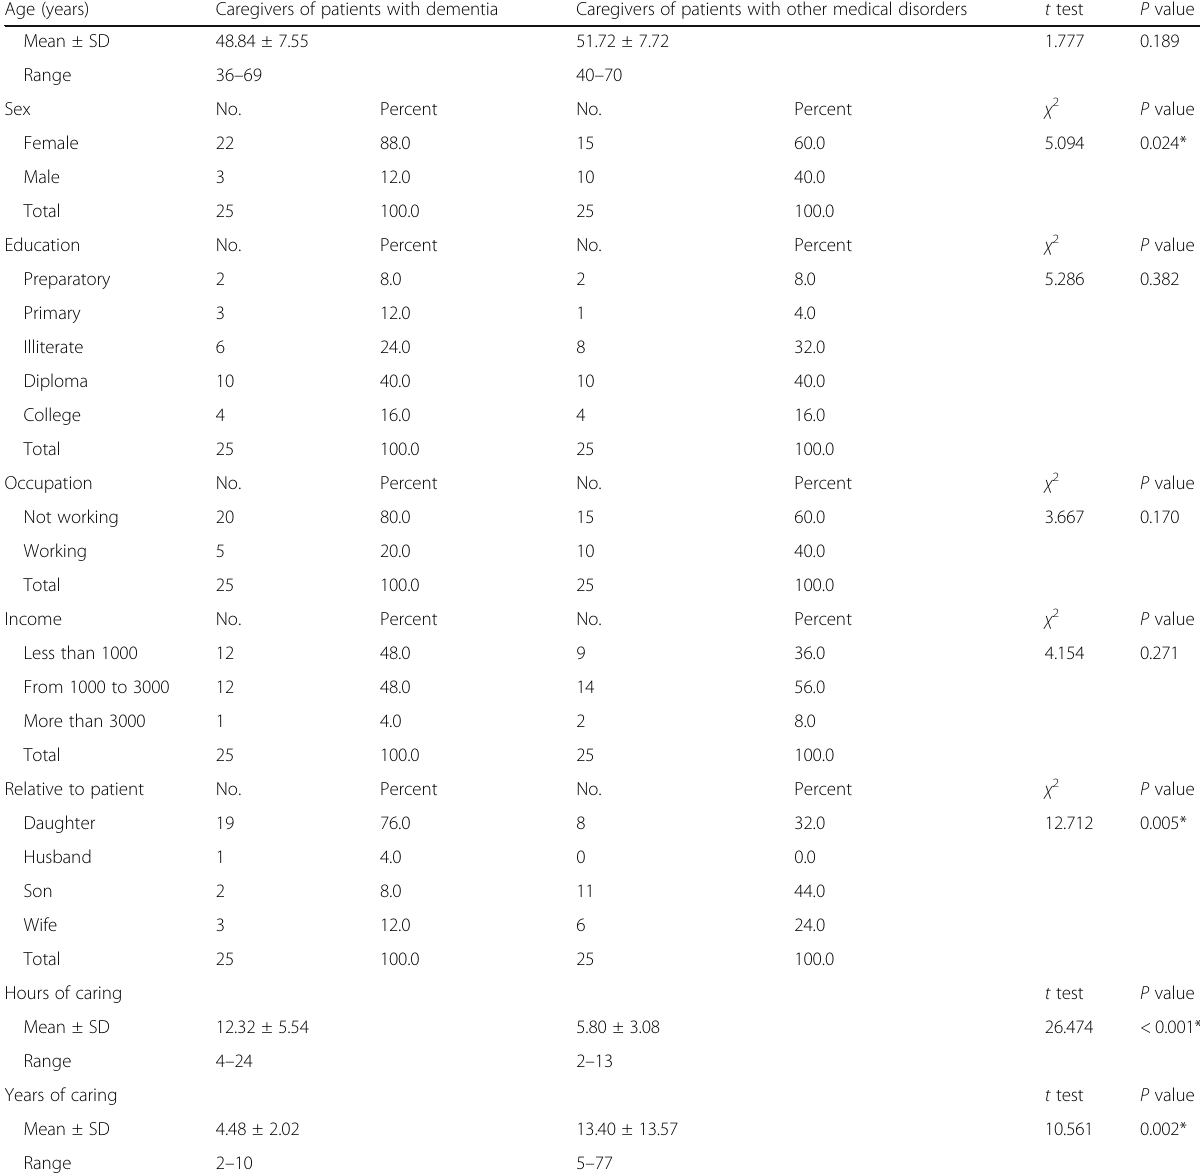
Table 1 Comparison between sociodemographics of both groups Age (years) Caregivers of patients with dementia